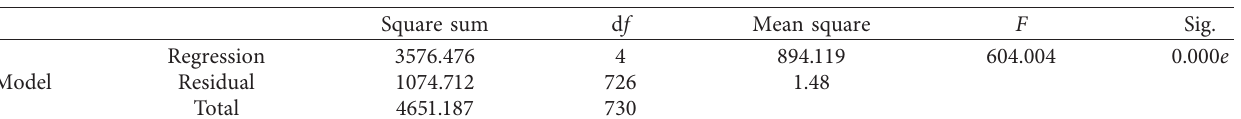
Table 10: Anova a .